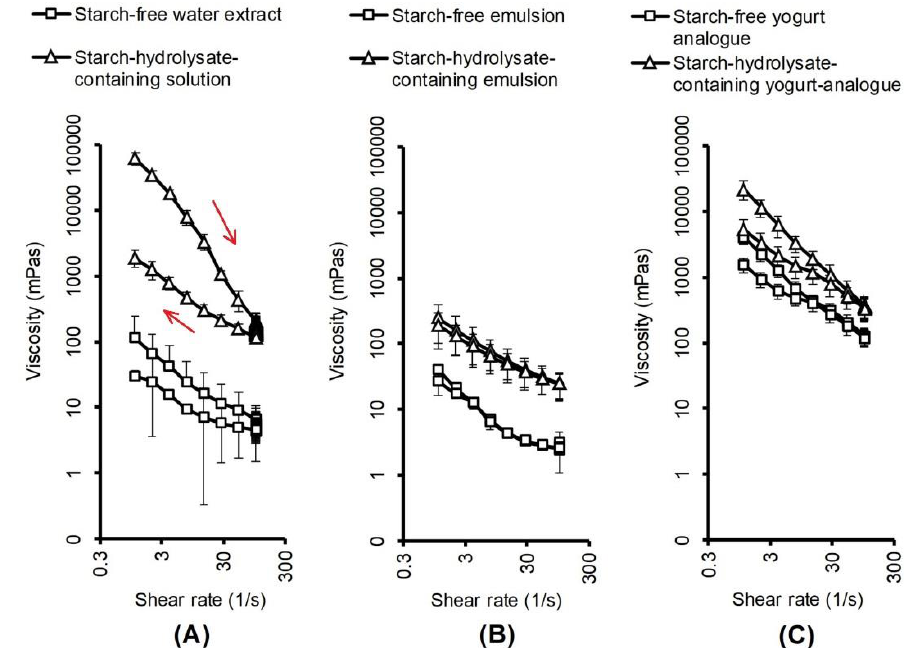
Figure 3. Viscosity of faba bean starch-free water extract (1.8% soluble protein content), and starch-hydrolysate-containing solution (1.8% soluble protein content) ( A ), the emulsions made from these solutions ( B ) and the yogurt analogues ( C ). Each point represents the average value of triplicate measurements with standard deviations. The arrows in the figure indicate the order of the data points of the starch-hydrolysate-containing solution. The viscosity in the up measurement (shear rate increasing) was higher than that in the down measurement (shear rate decreasing). The other curves had similar order.